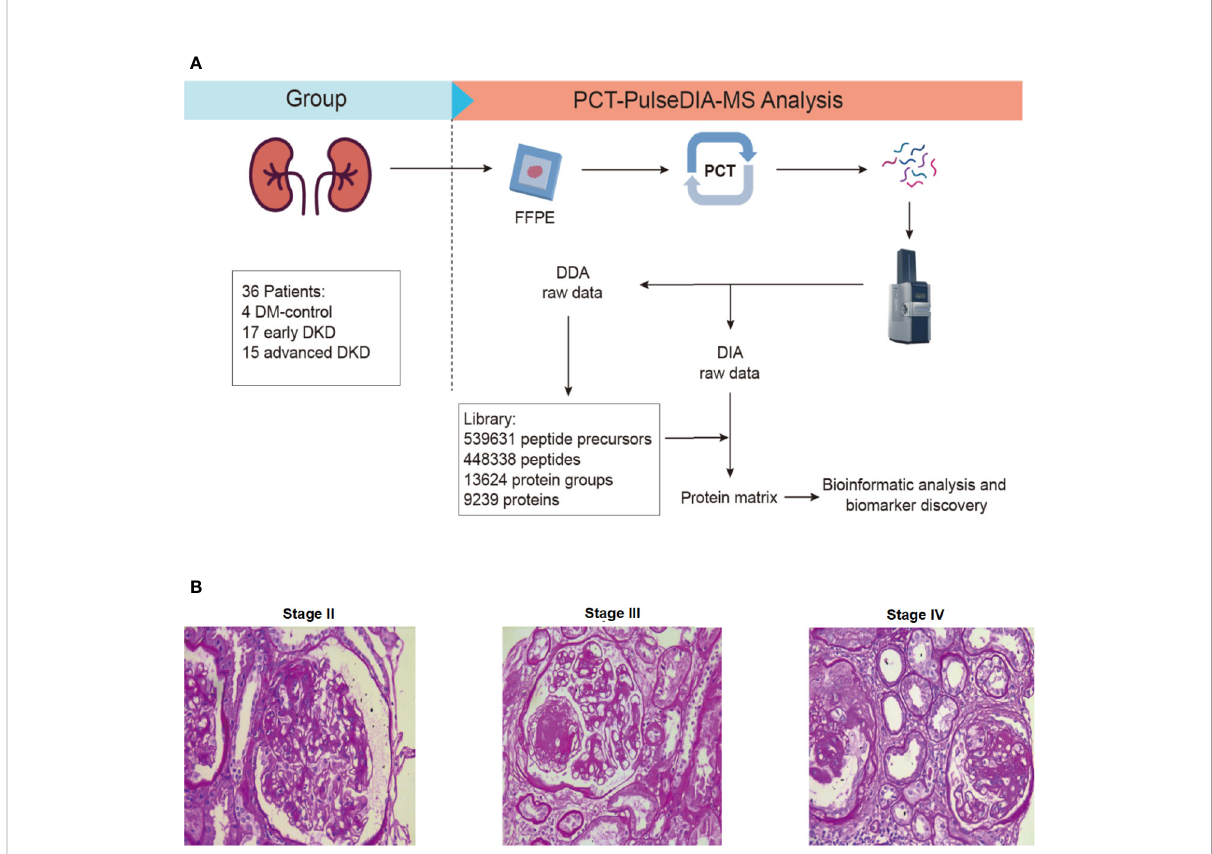
FIGURE 1 Study design. (A) FFPE-PCT-PulseDIA project design and work fl ow. (B) Histopathological characteristics of stage II, III, and IV DKD. FFPE: formalin- fi xed paraf fi n-embedded; DKD: diabetic kidney